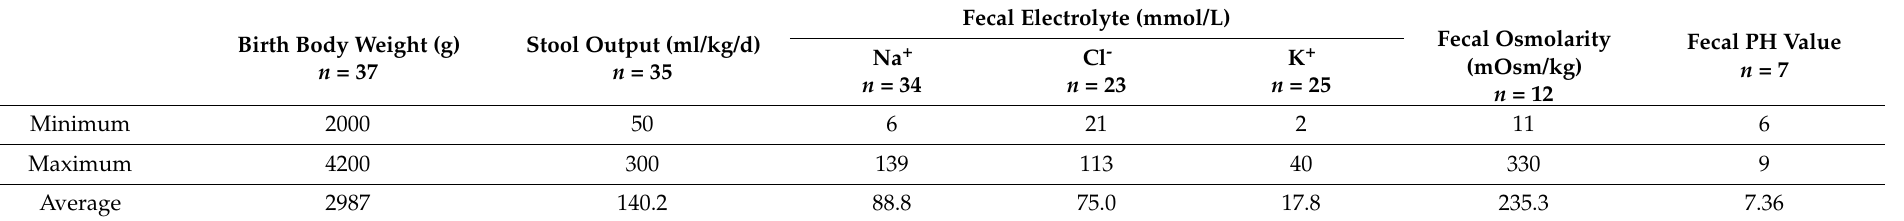
Table 2. Summary of the clinical details from published MVID case